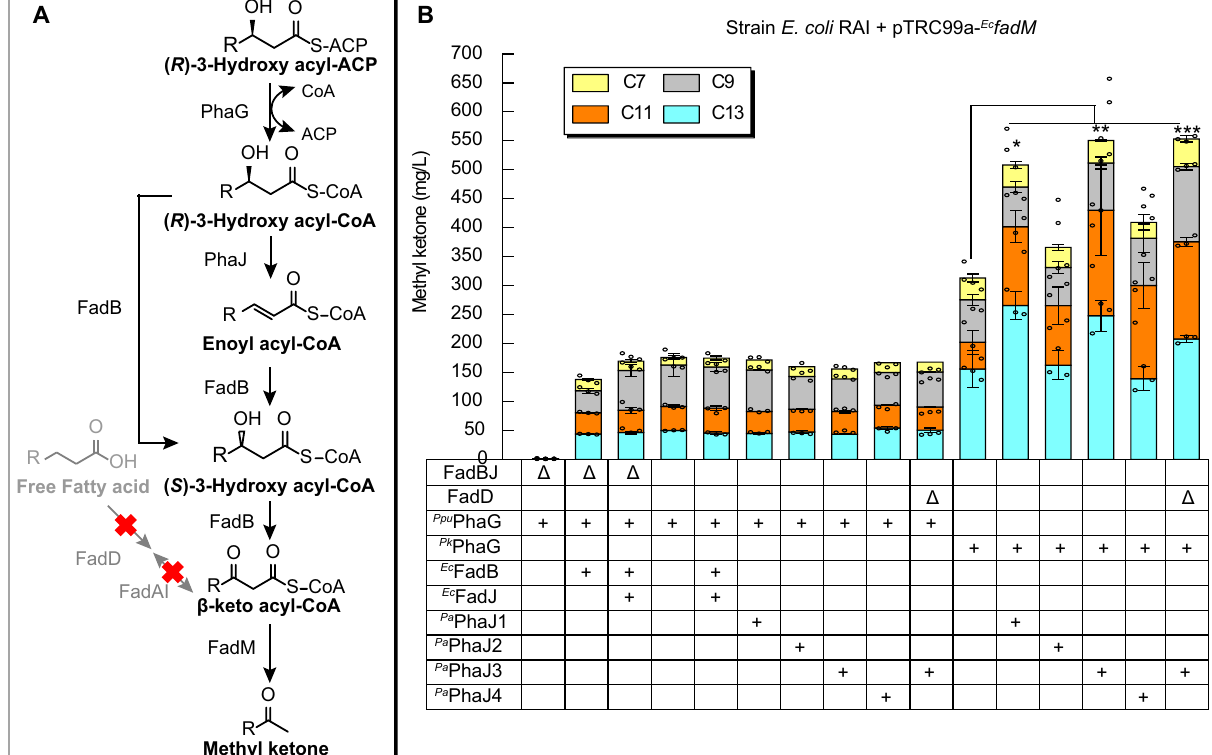
Fig. 3 Metabolic engineering to enhance methyl ketone production. A Detailed metabolic pathway is used to enable PhaG-dependent production of methyl ketones. B Evaluation of alternative routes of isomerizing 3-hydroxyacyl-CoAs with respect to PhaG activity. A series of mutations were made to the base strain, E. coli RAI (MG1655, Δ araBAD Δ fadR Δ fadA Δ fadI ) ( n = 3 biologically independent samples). Cultures of each strain harboring pTRC99a- Ppu phaG - Ec fadM or pTRC99a- Pk phaG - Ec fadM were grown for 48 hrs in Clomburg medium containing 20 g/L glycerol at 30 °C and shaking at 250 r.p.m. All data represent the mean ± s.d. of biological triplicates. *** P = 0.0001, ** P = 0.003, * P = 0.02 were analyzed based on student two-tailed t test assuming unequal variances. Source data underlying B are provided as a Source Data fi